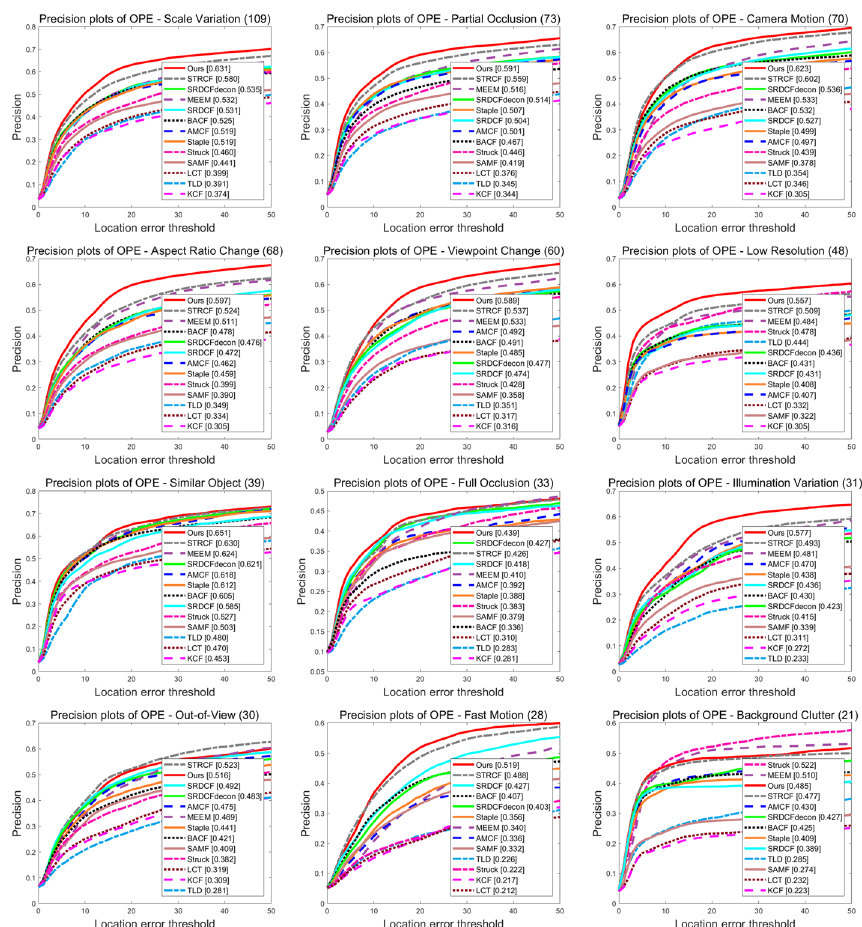
Fig. 6 Precision plot of different attributes of all trackers on 123 UAV